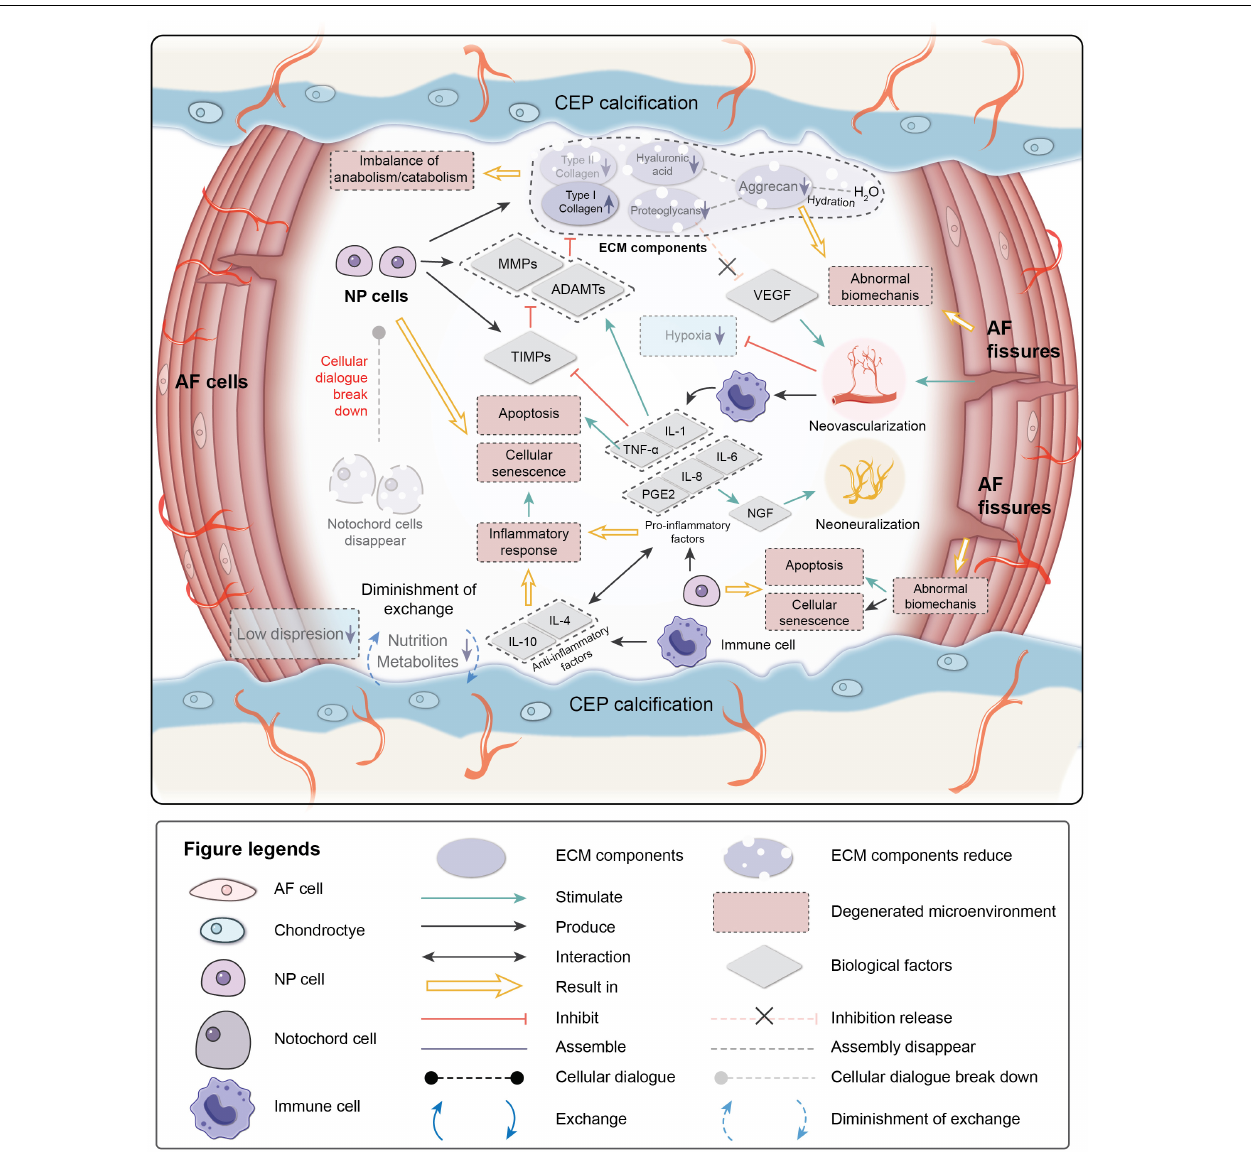
FIGURE 2 | Pathological microenvironment of intervertebral disk (IVD). AF, annulus fibrosus; NP, nucleus pulposus; CEP, cartilage endplate. ECM, extracellular matrix; MMPs, metalloproteinases; ADAMTs, metalloproteinase with thrombospondin motifs; TIMPs, tissue inhibitors of metalloproteinases; VEGF,